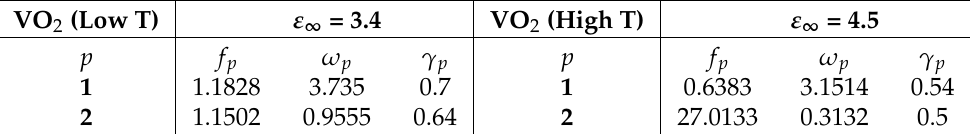
Table 1. The parameters of two poles of the Drude–Lorentz model for the dielectric constant of VO 2 from the visible to the IR region, directly taken from Ref. [44]. Here, the unit of ω p and γ p are ¯ h − 1 eV. VO 2 (Low T) ε ∞ = 3.4 VO 2 (High T) ε ∞ = 4.5 p f p ω p γ p p f p ω p γ p